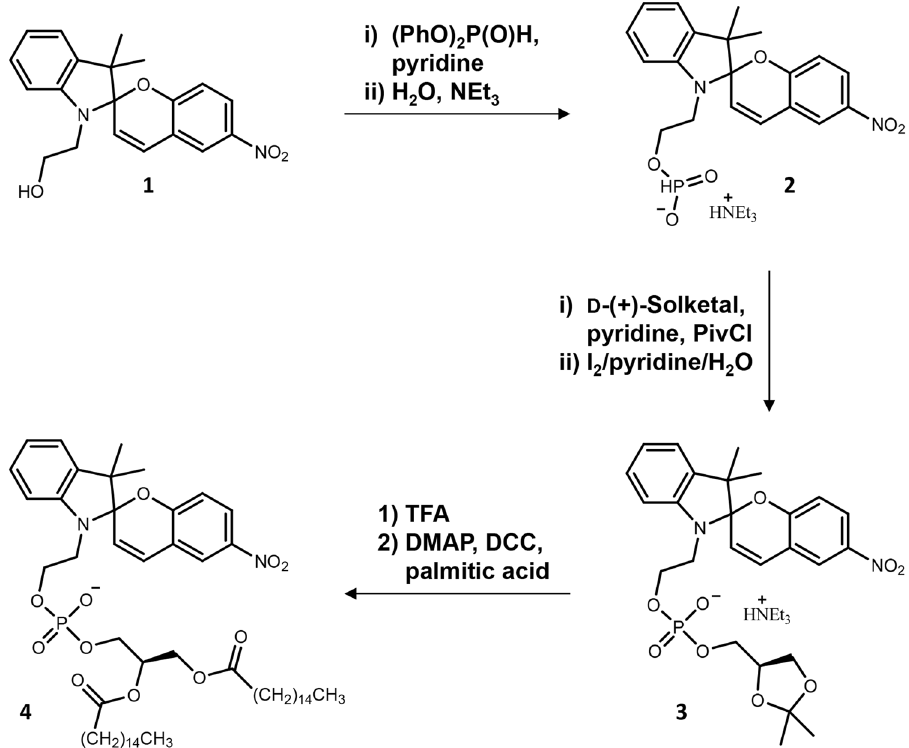
Figure 1. Synthesis of 1,2-dipalmitoyl-sn-glycero-3-phosphoryl-2-(3 ′ ,3 ′ -dimethyl-6-nitrospiro[1-benzopyran- 2,2 ′ -1 H -indolin]-1 ′ -yl)ethane ( N -nitroBIPS-DPPG) (4). 1,